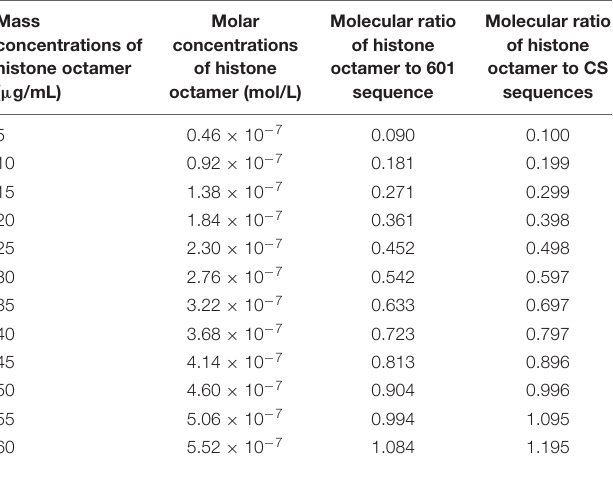
TABLE 1 | The concentrations of histone octamer and the ratios of histone octamer to DNA in reaction